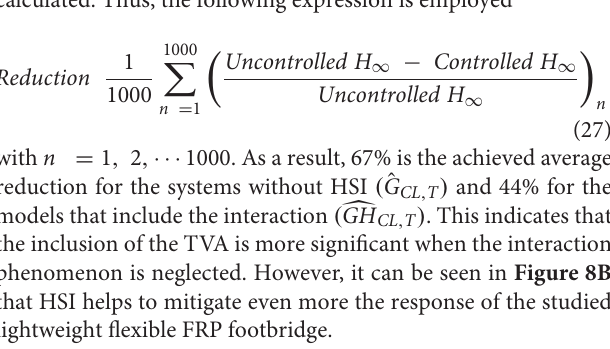
every individual of the population is a vector that contains two variables. Finally, the population size and the maximum number of generations or iterations are set to 50. The design in each scenario is described in the next